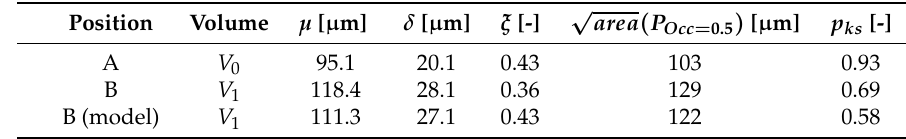
Table 3. Statistically evaluated distribution parameters of the generalized extreme value distribution